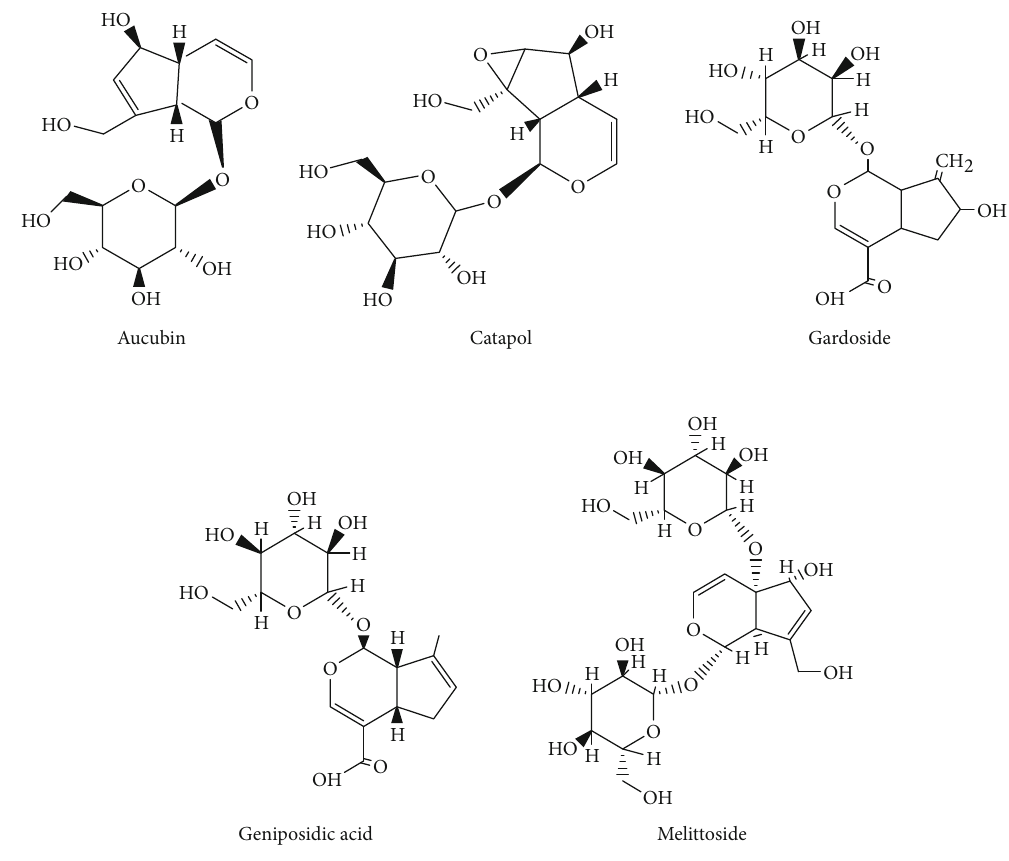
Figure 6: Iridoid glucosides and phenylethanoid glycosides isolated from P. lanceolata L.